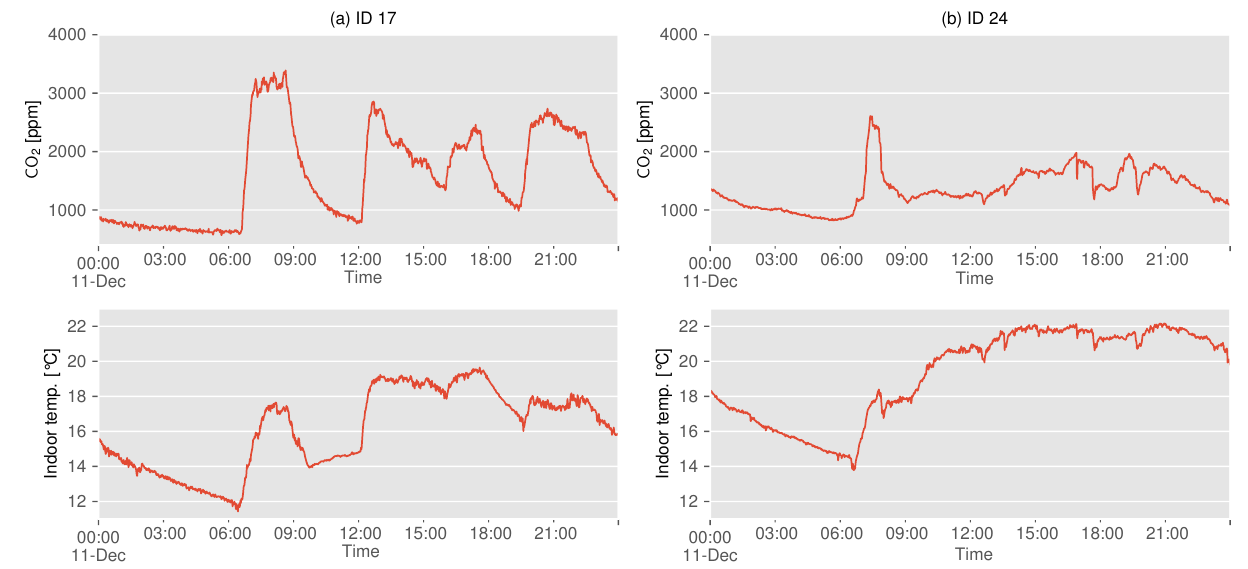
Figure 5. Indoor CO 2 concentration and temperature when combustion heater is used at ID 17 and